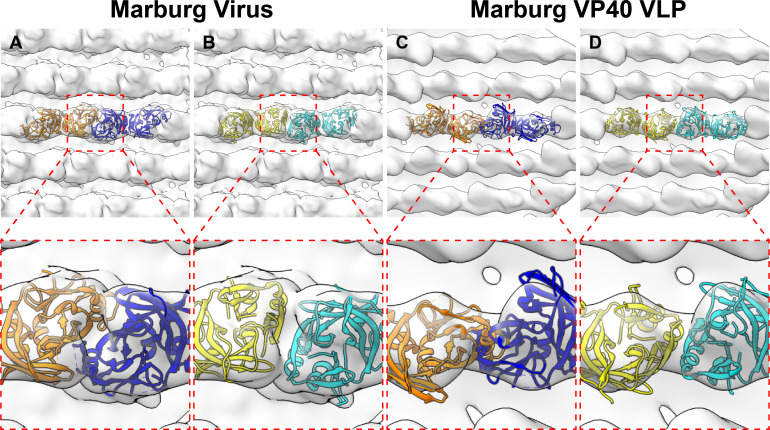
Rigid body fitting of crystal structures into mVP40 matrix layers.(A and B) are densities from Marburg virus while (C and D) are densities from mVP40 VLPs. mVP40 crystal structures (PDB: 5b0v) are in blue and orange while eVP40 structures (PDB: 4ldb) are in cyan and yellow. For Marburg virus, both structures fit without clashing, while in Marburg VP40 VLPs only the eVP40 structures fit, suggesting a conformational change between the mVP40 crystal structure and the VLP.